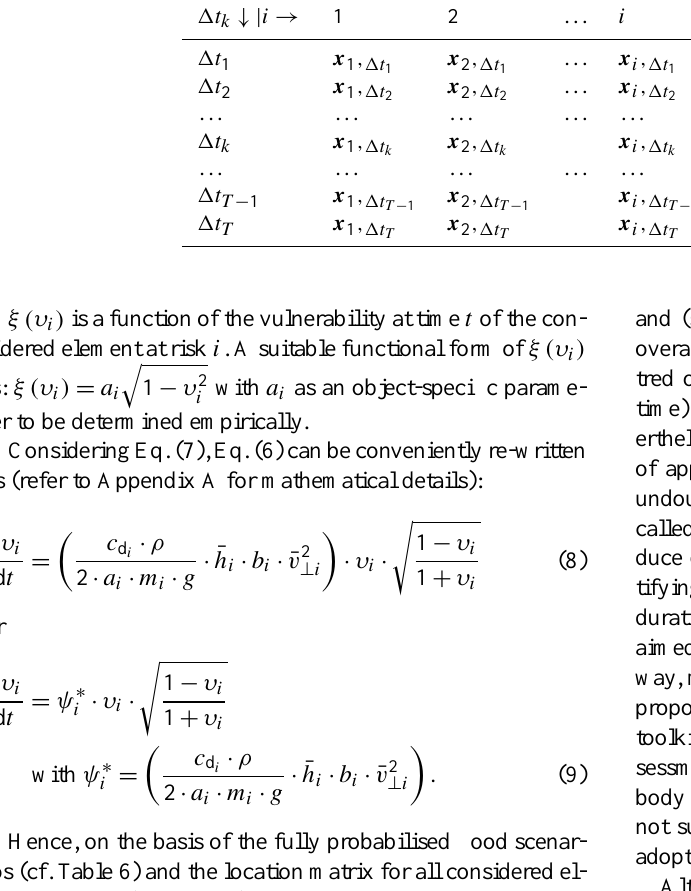
Table 7. Matrix of locations x i = x i (t) (deterministic case). 1t k ↓ | i